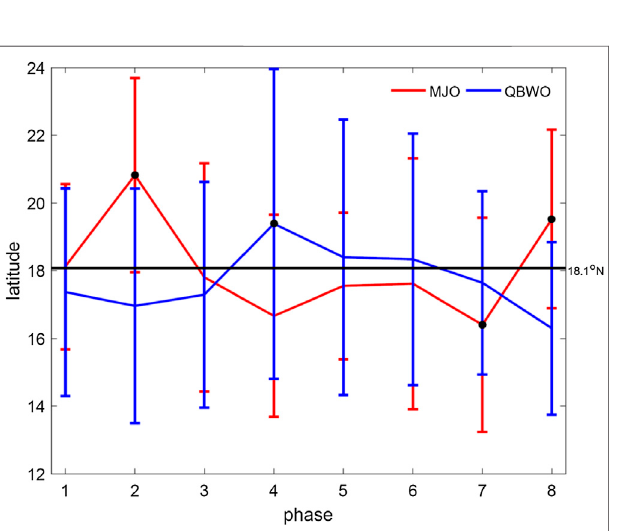
FIGURE 7 | The average minimum sea level pressure (MSLP, hPa) and its standard deviation of the nonlocal TCs when they entered the SCS in each phase of MJO (red) and QBWO (blue). The black line indicates the mean entry intensity. The black dots denote the values exceeding 95% con fi dence level basing on the Student ’ s t